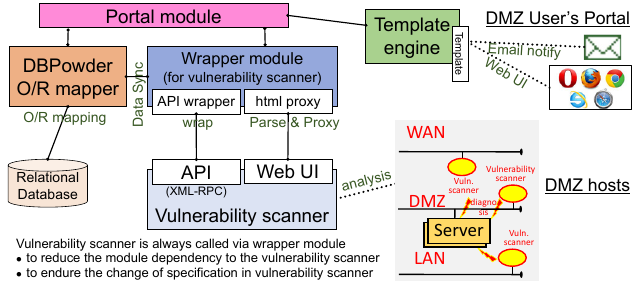
Figure 4: System architecture of DMZ User’s